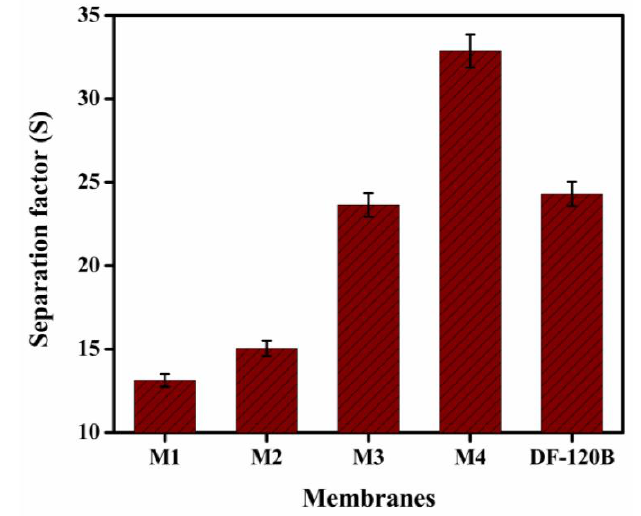
Figure 14. Separation Factor at 25 °C for multiple representatives for porous BPPO-based mem- branes.